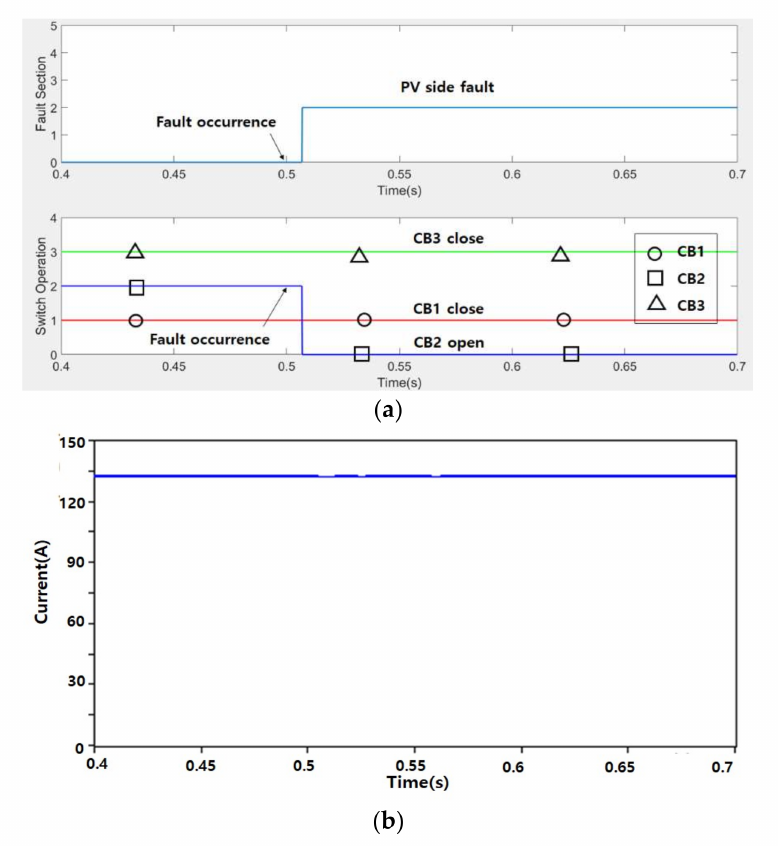
Figure 14. Simulation results of Case 2: ( a ) Fault section and CB operation and ( b ) Load